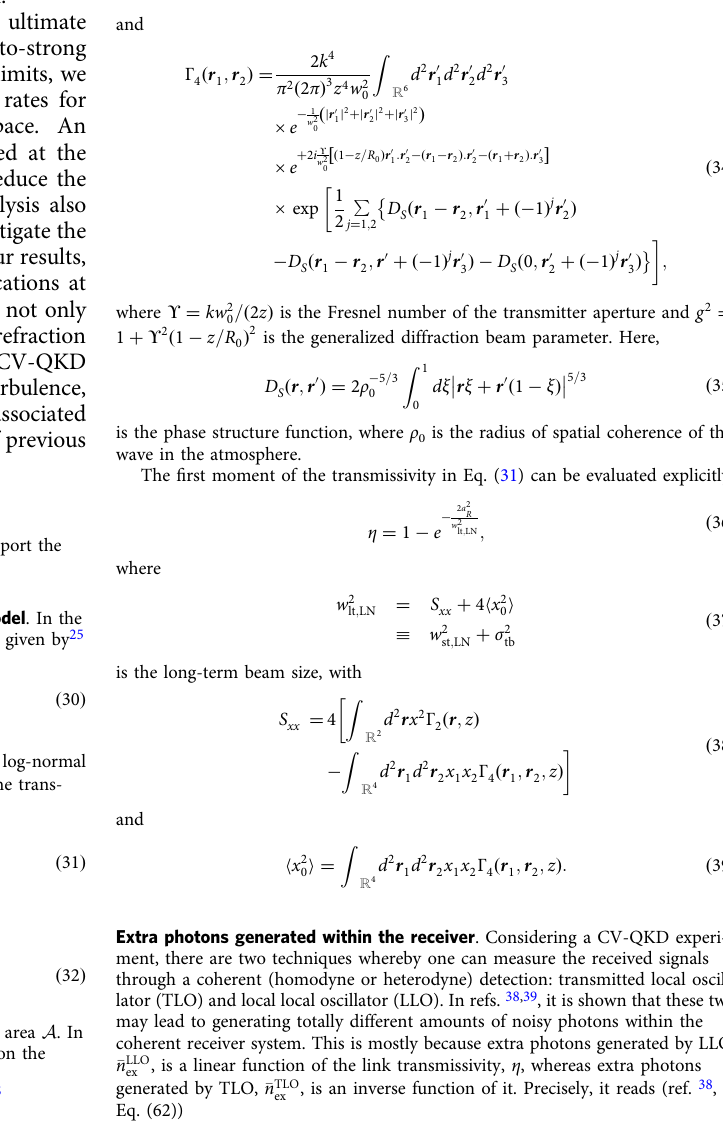
Fig. 7 Extra noise photons generated within a coherent receiver (homodyne detection). Here, we consider night- (solid black curves) and day- time (dashed blue curves) when a TLO/LLO technique is used. We have ffiffiffiffiffiffiffi p ν ¼ 1 SNU, NEP ¼ 6pW = Hz , W = 100MHz, Δ t LO = 10ns, P LO = 100mW, det V = 8SNU, l = 1.6KHz, C = 5MHz, and hc = 1.986×10 − 25 J.m. Other A w parameters related to η are set as in